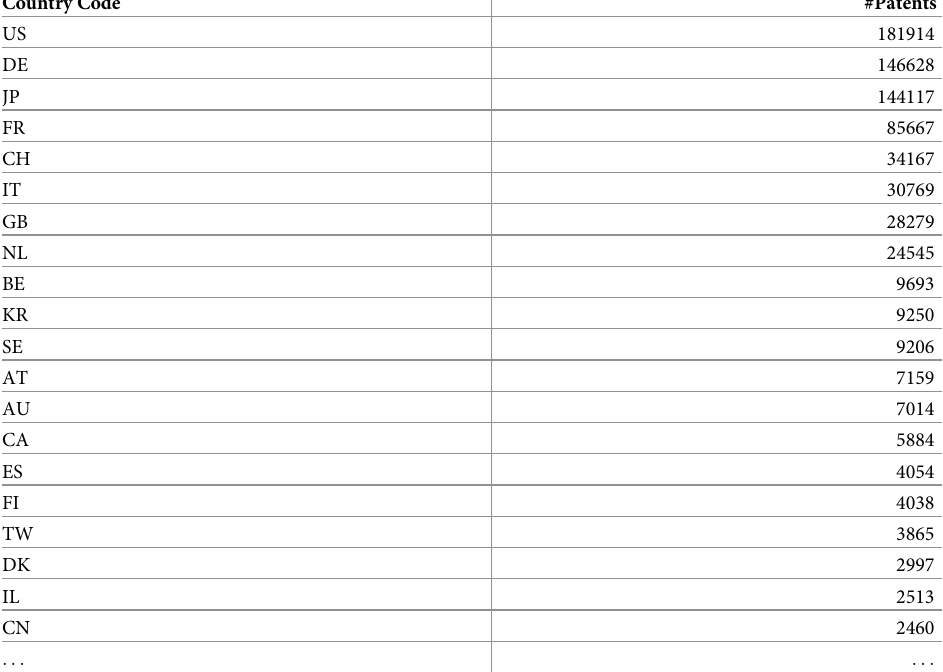
Table 5. Patent distribution by country (Top-20).